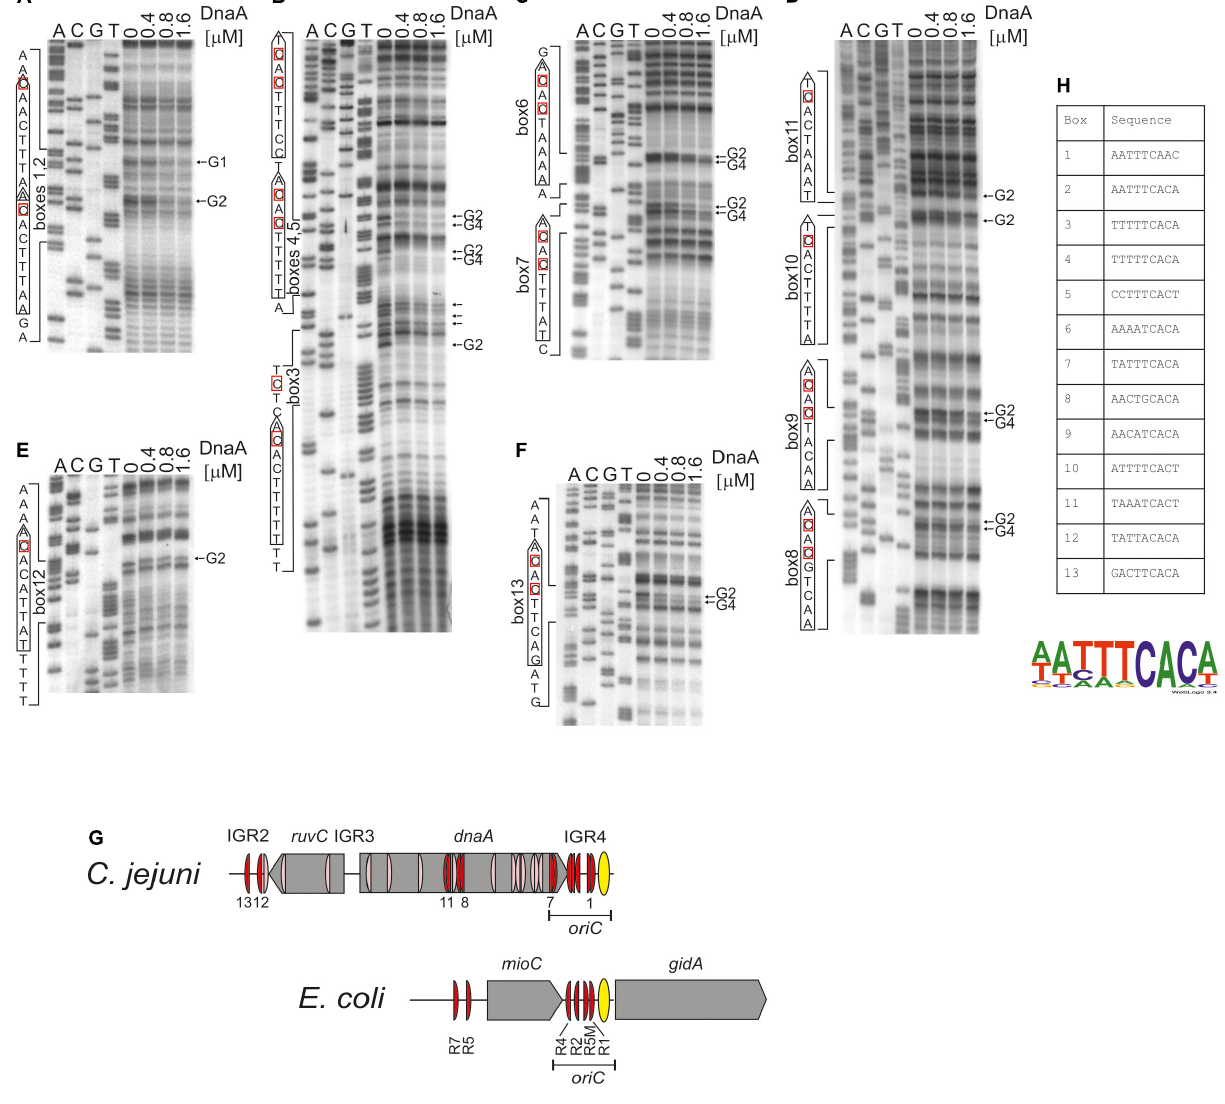
(Supplementary Table S1) was incubated with the StrepCjDnaA protein. The StrepCjDnaA protein contained a C-terminal Strep- tag and a native N-terminus, which might be essential for long- range protein–protein interactions (Zawilak-Pawlik et al.,